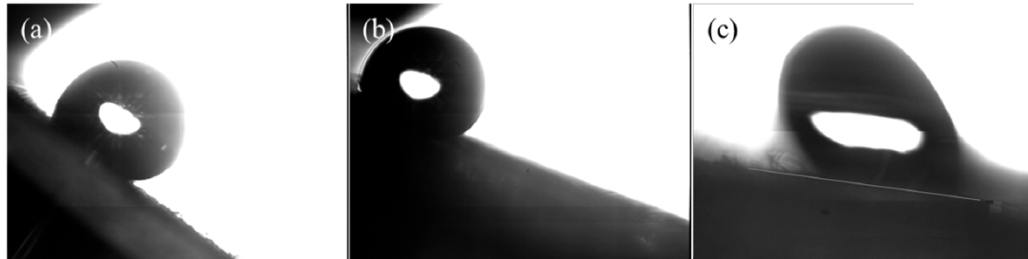
Figure 5. The critical roll angle measured at di ff erent precursor values, ( a ) 20 g / h, ( b ) 30 g / h, and ( c ) 40 g / h, with the other conditions being 300 V and two treatments.